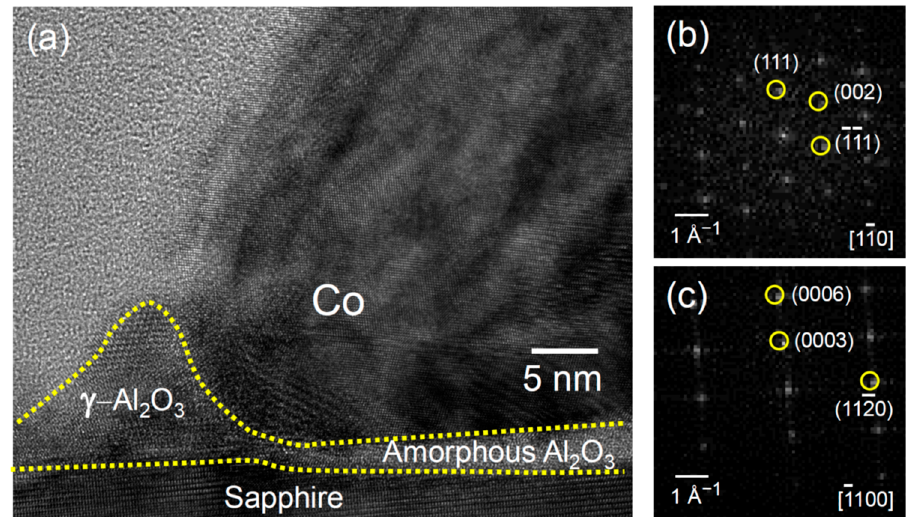
Figure 4. ( a ) TEM image illustrating the region near the contact line that exhibits the deformation of substrate signified by the γ -Al 2 O 3 wetting ridge and the amorphous Al 2 O 3 interlayer. ( b ) FFT pattern of the γ -Al 2 O 3 crystal confirming its face centered cubic (FCC) structure with a lattice constant of 0.79 nm. ( c ) FFT pattern of the crystalline sapphire substrate for comparison. Scale bar represents the reciprocal space unit.